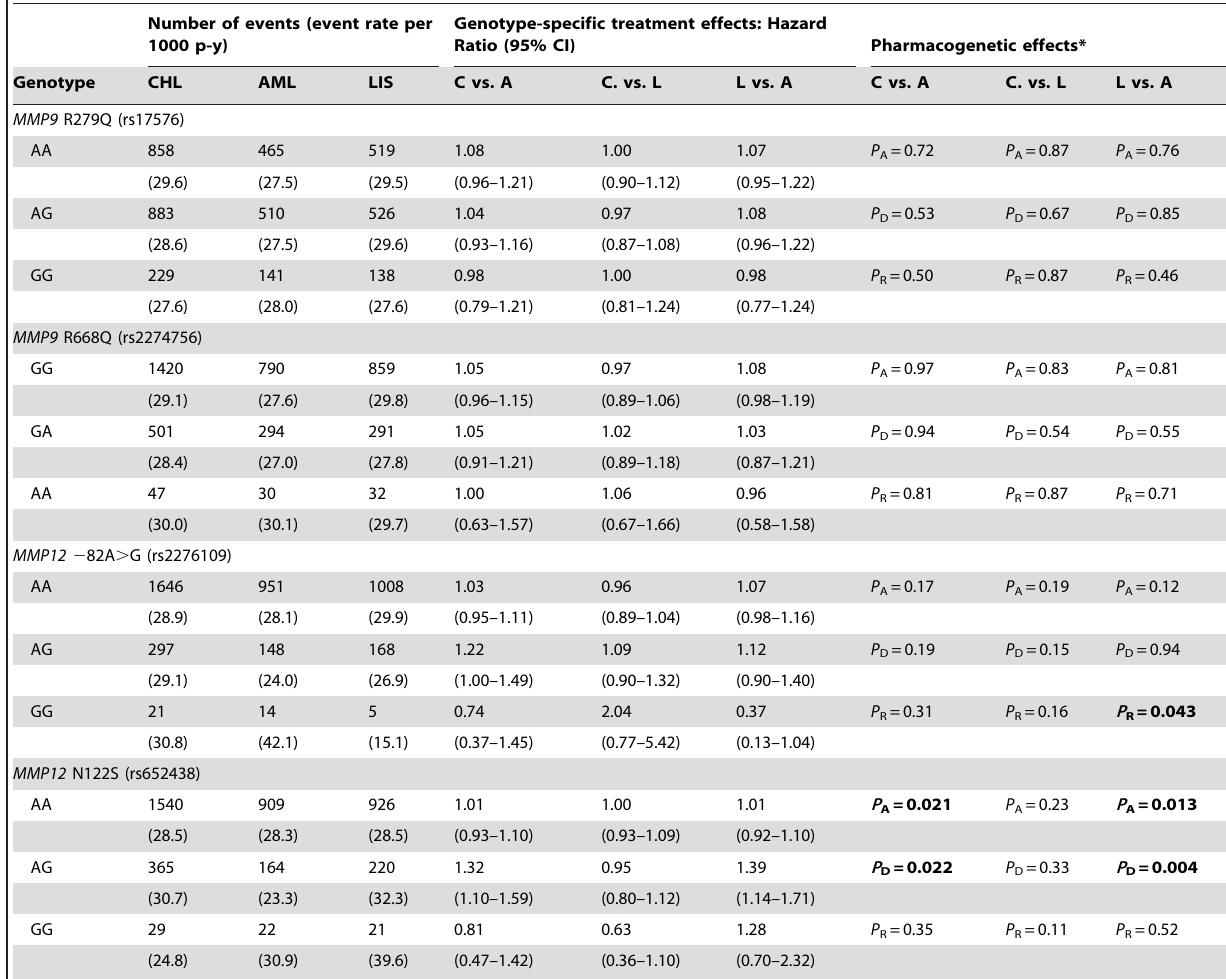
Table 6. Pharmacogenetic effects of MMP genetic variants on ACM.